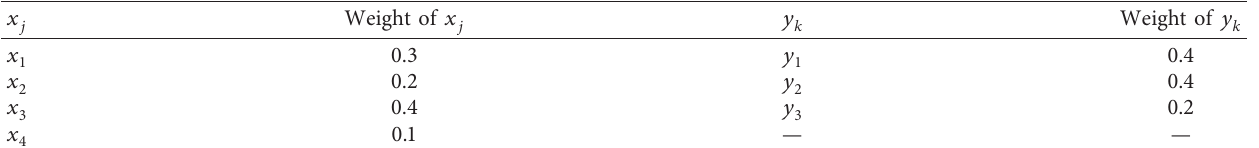
Table 6: Scores of a